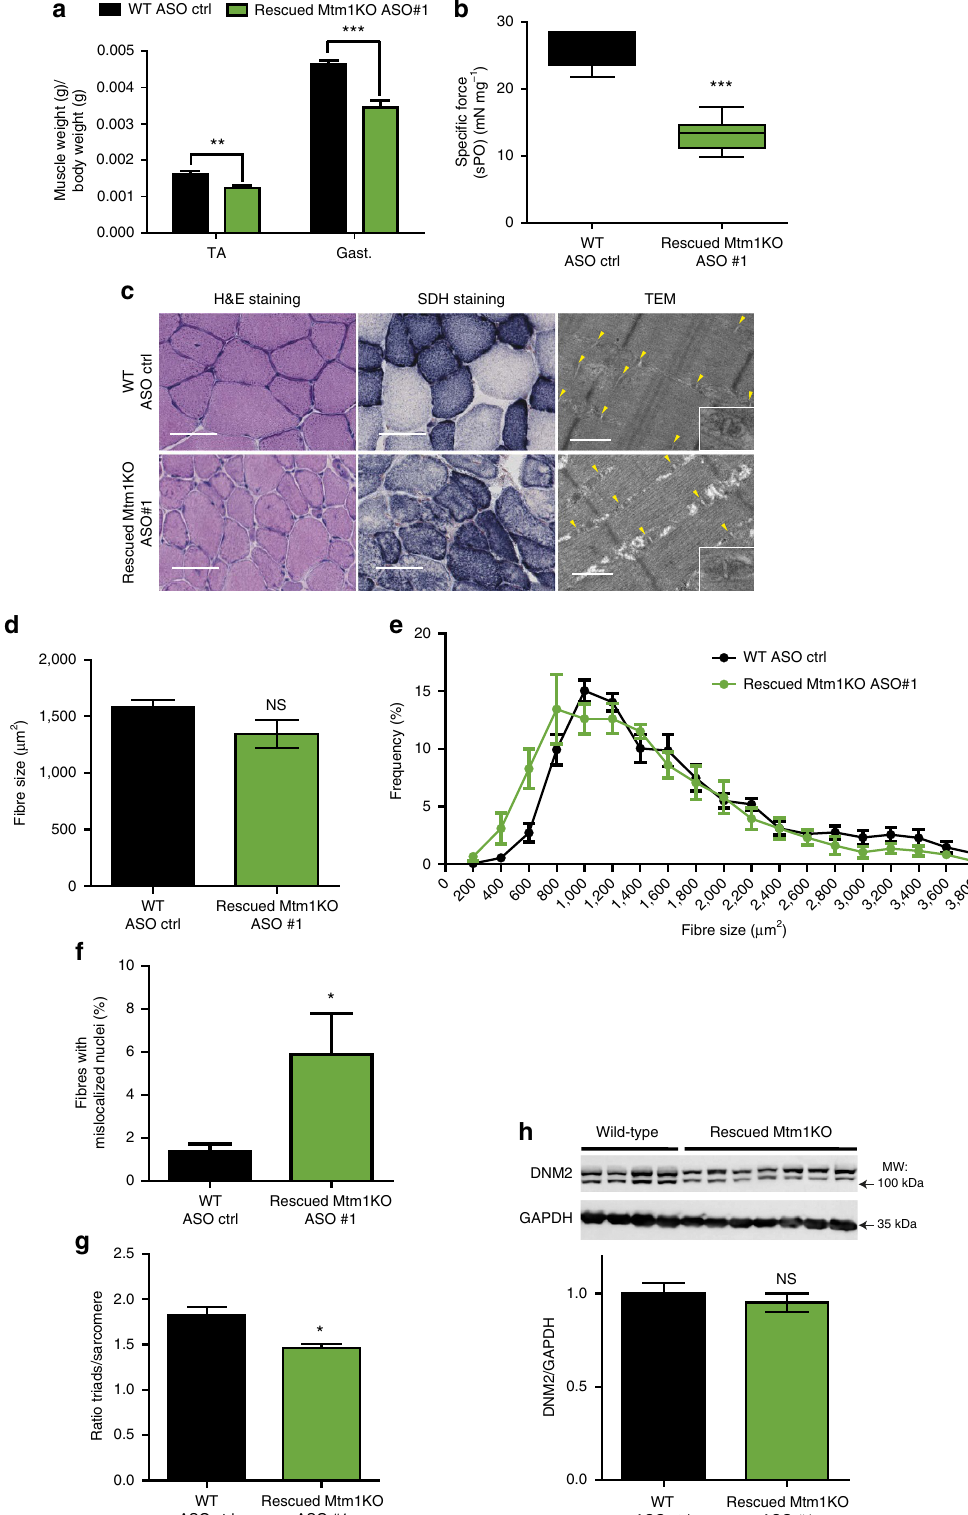
Figure 9 | Physiological improvements of CNM phenotype in severely affected Mtm1KO mice. ( a ) TA and gast. muscles weight and ( b ) in situ specific muscle force at week 12 and following 8 weeks of ASO treatment. ( c ) TA muscle sections were stained with H&E or SDH. Scale bar, 50 m m for histology and 500nm for TEM. Yellow arrows point to organized triads. ( d ) Fibre size average was quantified in 400–600 fibres ( n ¼ 5). ( e ) TA muscle fibre area distribution of Mtm1KO mice injected with ASO#1 versus WT injected with ASO control ( n ¼ 5). ( f ) Fibres with abnormal position of nuclei ( n ¼ 5). ( g ) Ratio of triads per sarcomere. ( h ) DNM2 and GAPDH (loading control) protein levels were measured in TA muscles by western blot. Data represent means ± s.e.m. NS, not statistically significant, * P o 0.05, ** P o 0.01, *** P o 0.001 ( t -test). kDa, kilodalton; MW, molecular weight. NATURE COMMUNICATIONS|8:15661|DOI: